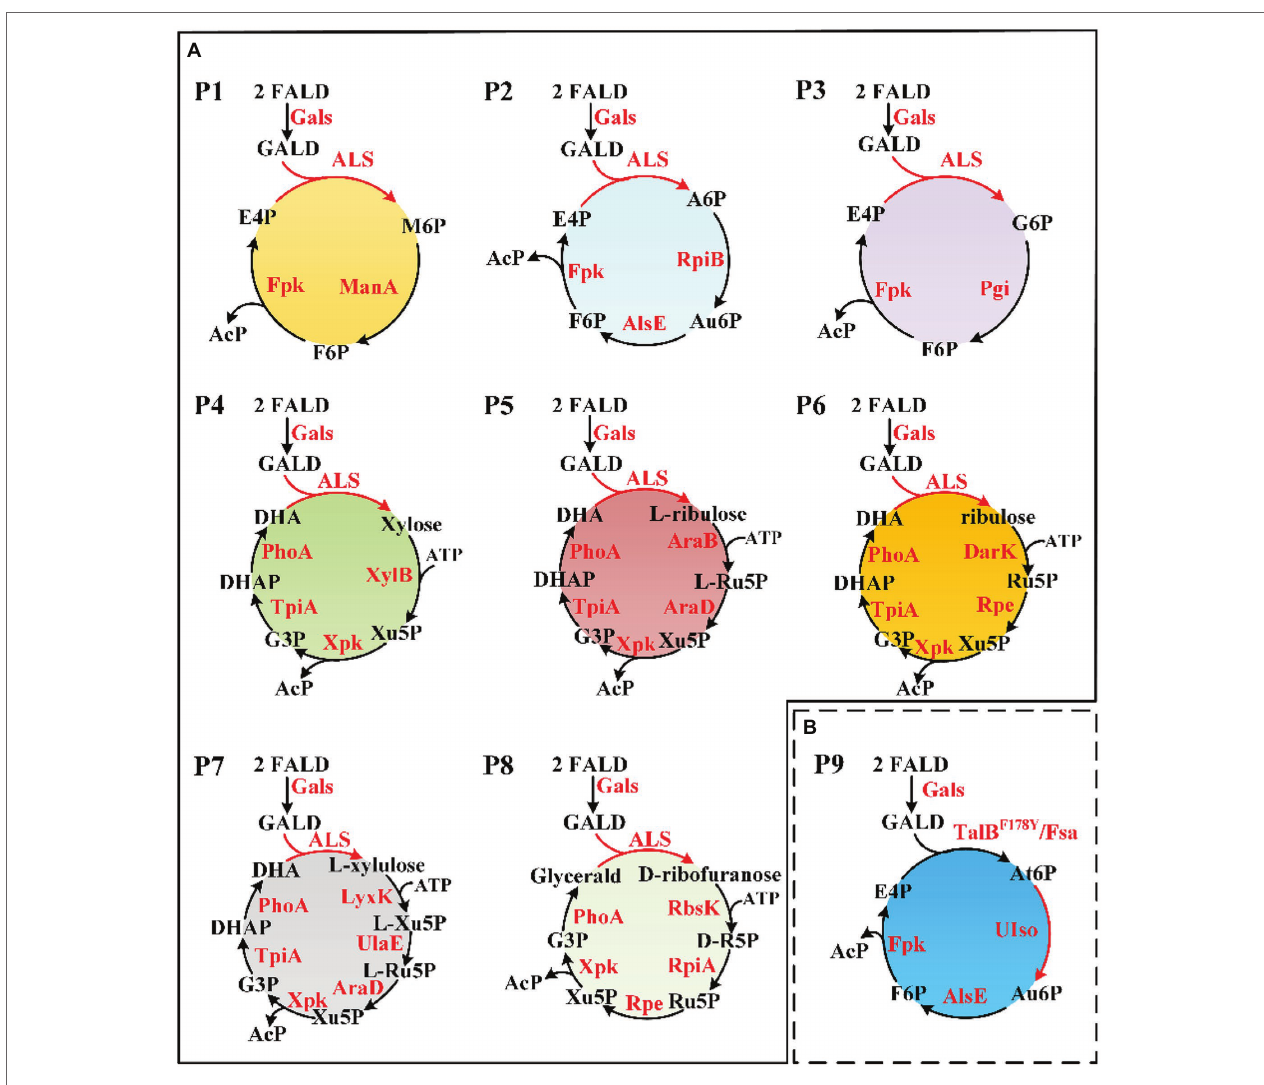
FIGURE 4 | Novel FALD assimilation pathways. (A) Predicted pathways (P1–P8). (B) Proposed novel pathway P9 based on TalB Y178F /Fsa. For simplicity, AcP to Ac (AcP => Acetate) was not shown. M6P, D-mannose 6-phosphate; A6P, D-allose 6-phosphate; Au6P, D-allulose 6-phosphate; G6P, D-glucose 6-phosphate; At6P, D-altrose 6-phosphate; AcP, acetyl-phosphate. Gals, evolved glycolaldehyde synthase; Fpk, fructose 6-phosphate phosphoketolase; ManA, mannose-6-phosphate isomerase; RpiB, allose-6-phosphate isomerase/ribose-5-phosphate isomerase B; AlsE, D-allulose-6-phosphate 3-epimerase; Pgi, glucose-6-phosphate isomerase; XylB, xylulokinase; Xpk, xylulose 5-phosphate phosphoketolase; TpiA, triose phosphate isomerase; PhoA, alkaline phosphatase; AraB, ribulokinase; AraD, L-ribulose-5-phosphate 4-epimerase; DarK, D-ribulokinase; Rpe, ribulose-phosphate 3-epimerase; LyxK, L-xylulose kinase; UlaE, L-ribulose-5-phosphate 3-epimerase; RbsK, ribokinase; RpiA, ribose-5-phosphate isomerase A; TalB, transaldolase; Fsa, fructose 6-phosphate aldolase; and UIso, unknown altrose 6-phosphate